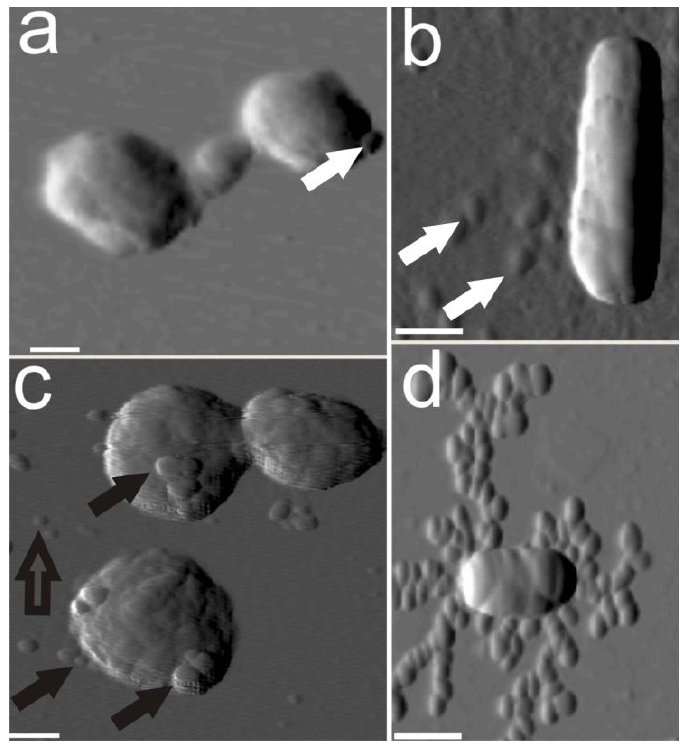
FIGURE 1 . A. laidlawii PG8 (a, c) and M. gallisepticum S6 (b, d) cells cultivated in favorable (a, b) and unfavorable (c, d) conditions. Bars correspond to 0.2 µm.